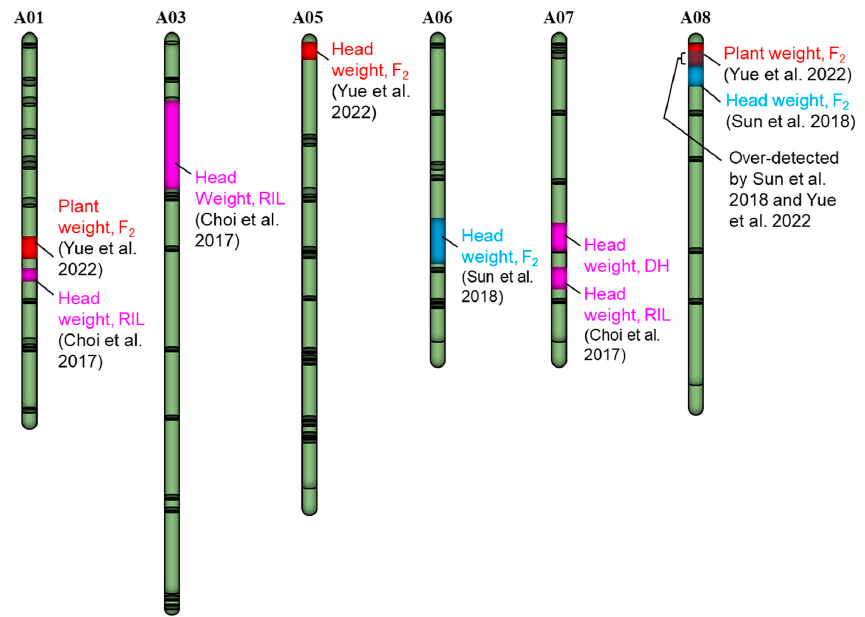
Figure 6. Chromosomal locations of yield heterosis in Chinese cabbage found by Yue et al.